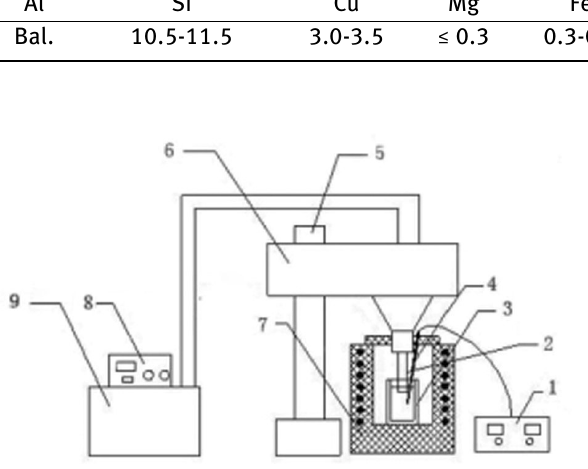
Figure 1: Schematic diagram of melt ultrasonic device